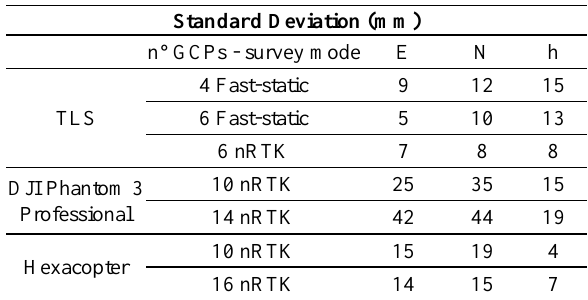
Table 5. Comparison of CPs SD in various